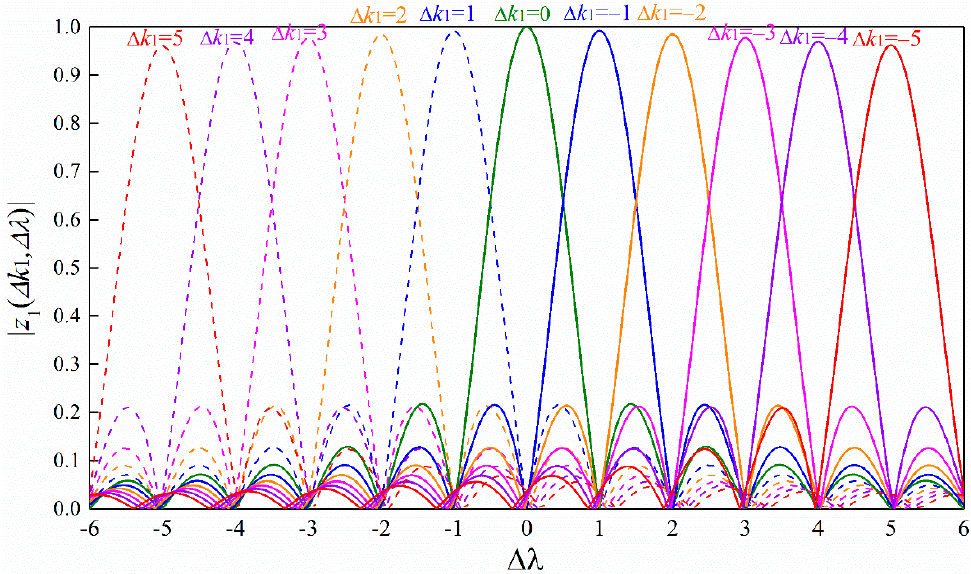
Figure 2. Illustration of the maximum correlator output of Zadoff–Chu (ZC) sequences with different roots ( N = 131).